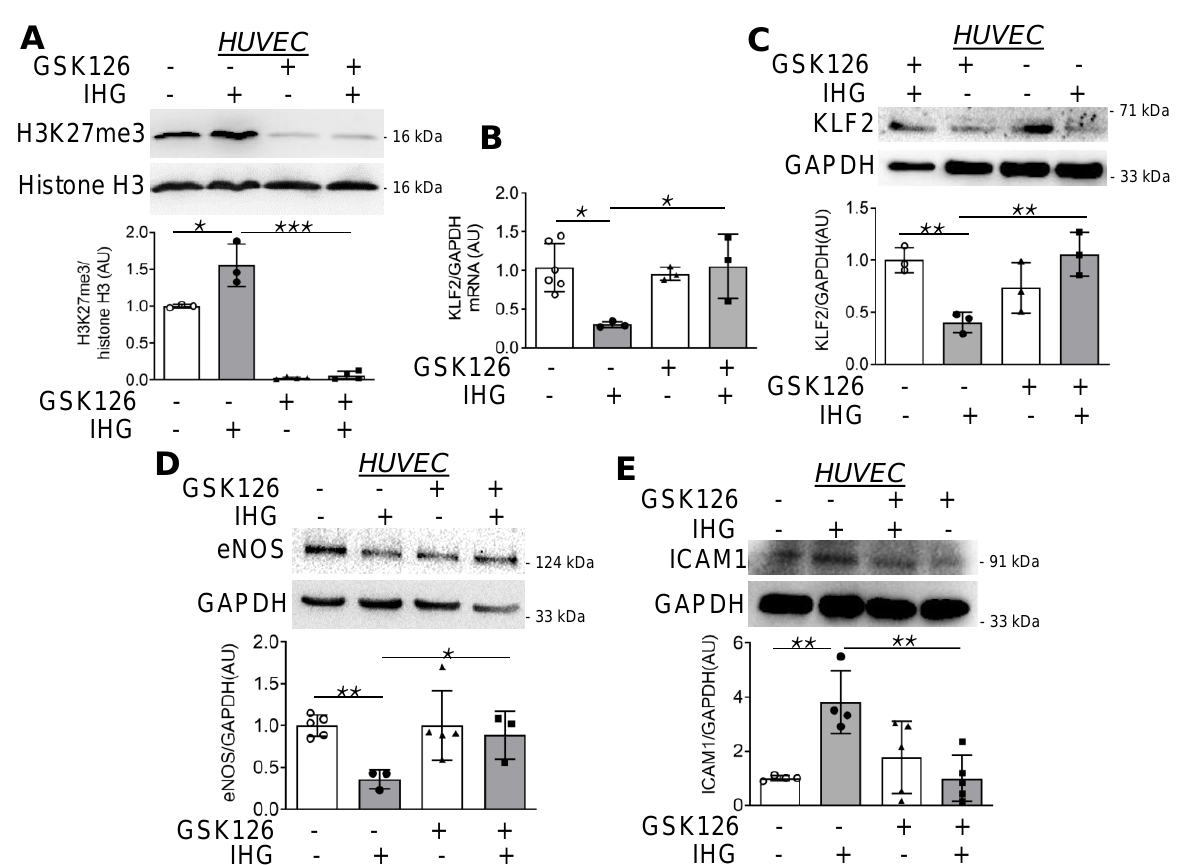
Figure 4. Small molecule-mediated inhibition of EZH2 in intermittent high glucose-exposed HUVEC decreases H3K27me3 level and blocks the inflammatory switch of EC. ( A ) Immunoblotting for H3K27me3 ( n = 3) in GSK126-treated and intermittent high glucose-exposed HUVEC. ( B ) KLF2 mRNA ( n = 3) expression in HUVEC challenged with intermittent high glucose (alternating 5.5 mM (normal glucose) and 25 mM (high glucose) cycle of 12 h for 3 cycles) in combination with GSK126 (10 µ M for 72 h). ( C – E ) KLF2 ( C ), eNOS ( D ), and ICAM1 ( E ) in cultured HUVEC treated with the EZH2 inhibitor GSK126 (10 µ M for 72 h) in combination with intermittent high glucose ( n = 3). Cells continuously exposed to normal glucose (5.5 mM) were considered as the non-intermittent high glucose treatment condition. All analyzed data were normalized to the control treatment condition. Values represent the mean ± SD. * p < 0.05, ** p < 0.01, and *** p < 0.001 by unpaired t test.